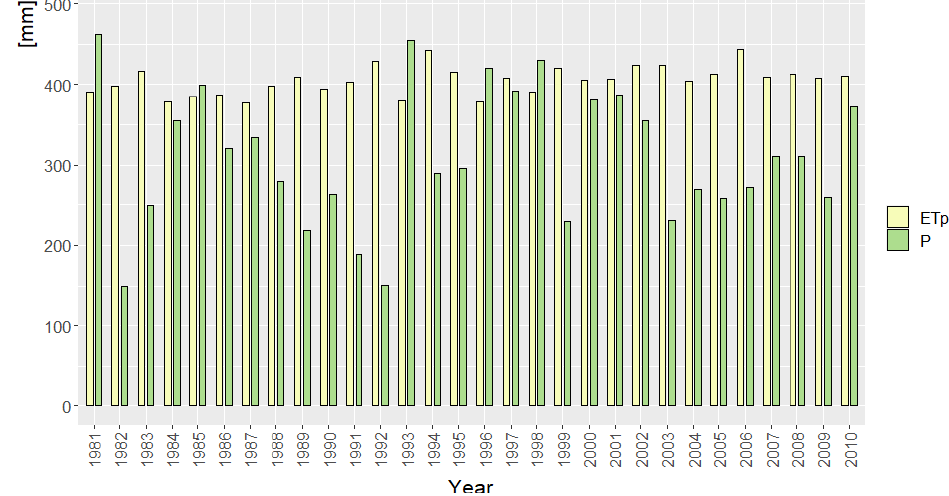
was in 2006 and amounted to 444 mm. The standard deviation of the ETp in the analyzed years was 17.4 (Table 2).